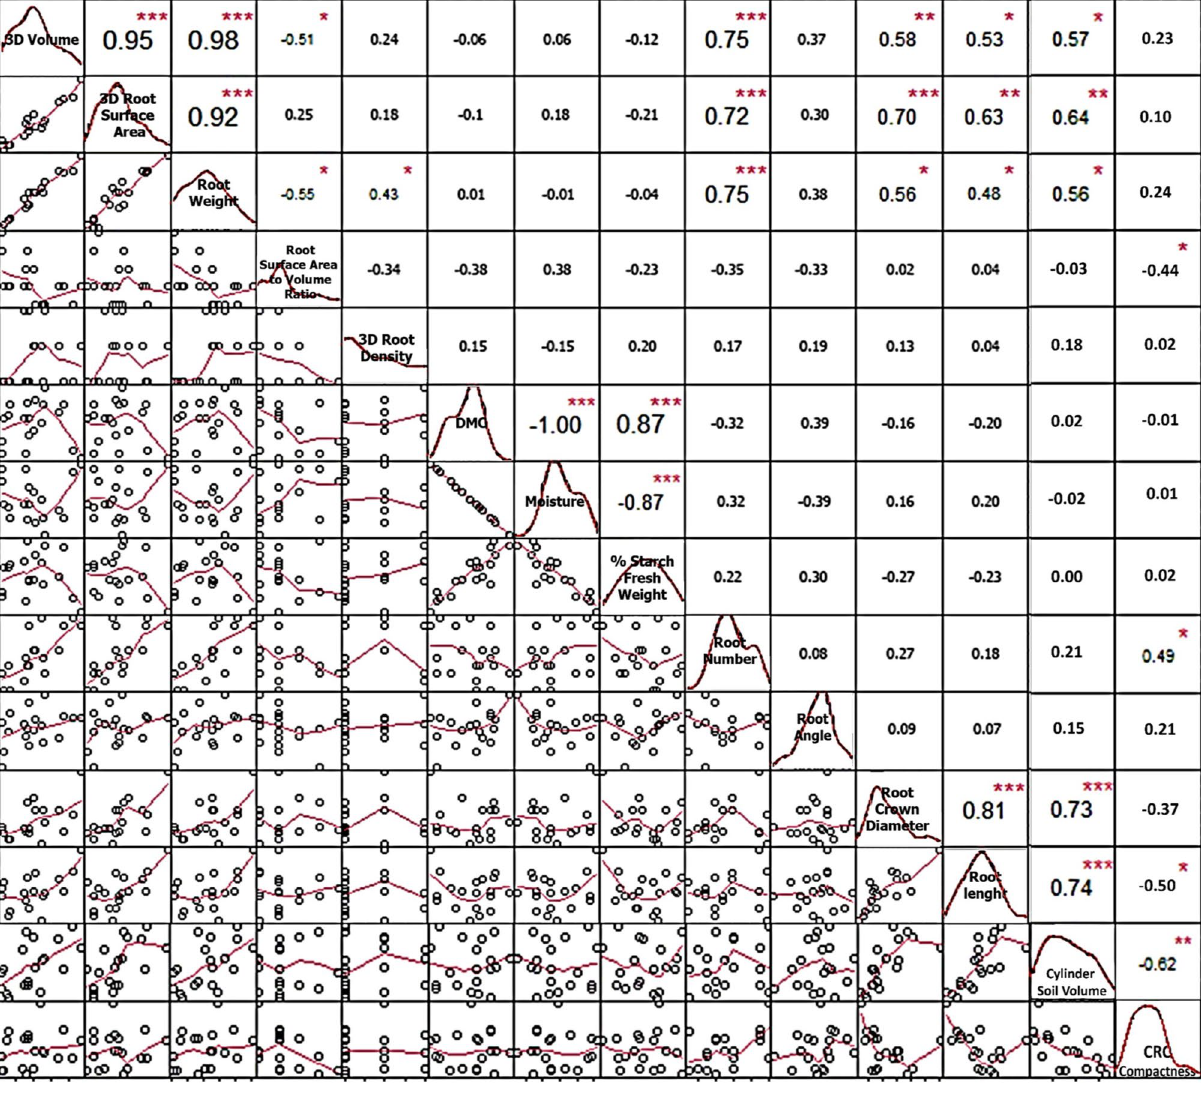
Figure 7. Correlation plots among 3D crown volumes (cm 3 ), 3D crown surface areas (cm 2 ), root weights (kg), surface-to-volume ratios, root density, DMC (%), moisture (%), starch content (% fresh weight), root number, root angle, root crown diameter (cm), average root length (cm) cylinder soil volume and CRC compactness obtained from 19 CRCs of seven cassava genotypes (df = 17). *, **, *** represent significant at P < 0.05, 0.01 and 0.001,